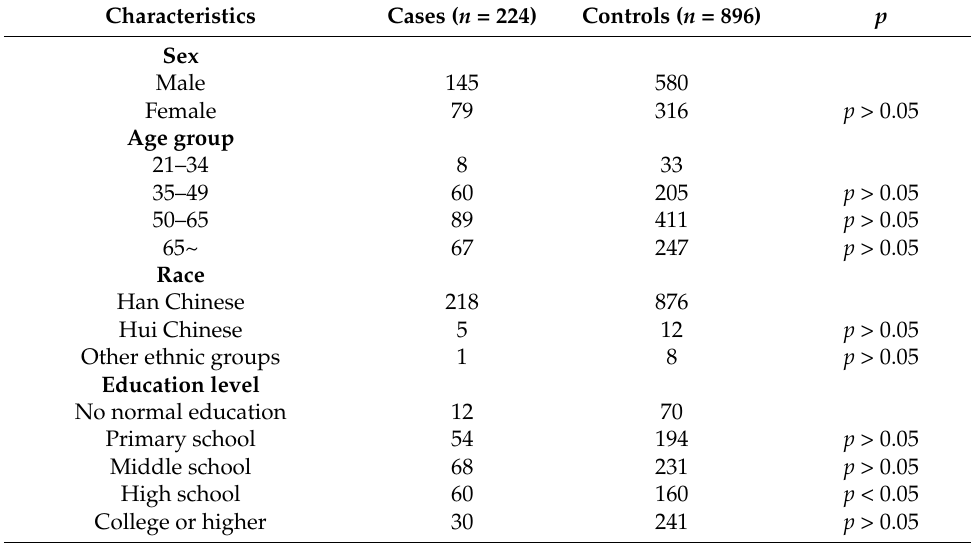
Table 1. Distribution of the characteristics of the COPD cases and matched controls nested at first follow-up period within the Jinchang Cohort Study